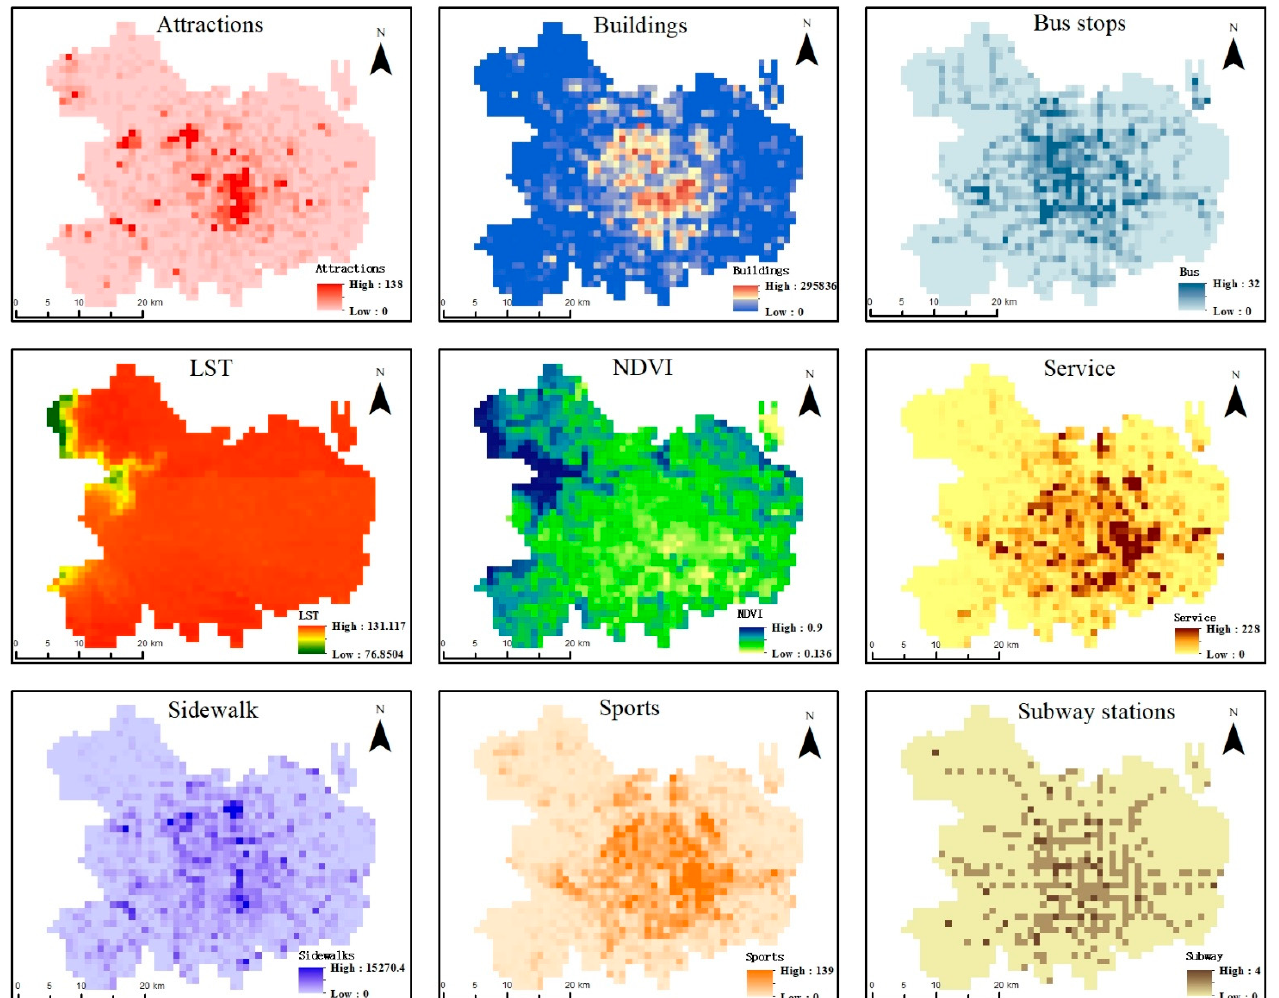
Figure 3. Spatial distribution of 9 environmental variables, all variables are in 1 km grid after calculation. Calculated the correlation matrix of 9 kinds of environmental variables and perform correlation analysis. As shown in Figure 4, there was a strong positive correlation between the sports variable and services variable (0.80), indicating that where the number of sports facilities was high, the number of public services facilities was also high.